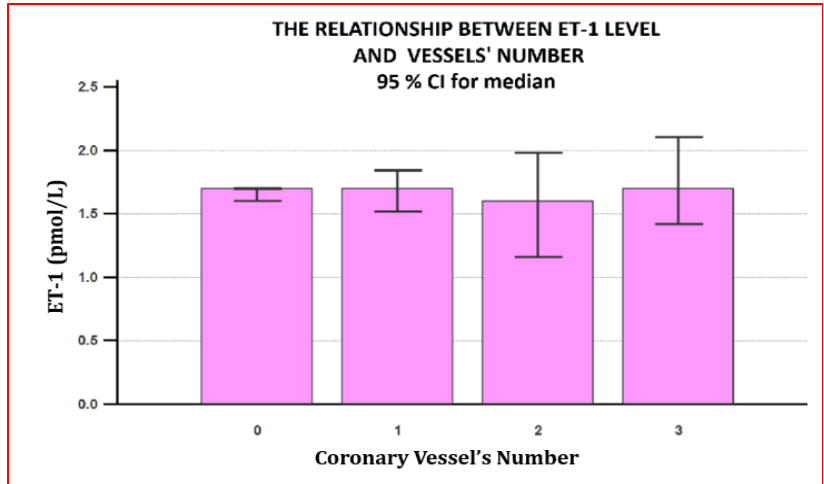
Figure 2. The relationship between plasma ET-1 concentration and the number of coronary lesions. The plasma concentration of ET-1 did not show significant differences either in terms of the type of coronary heart disease, microvascular versus macrovascular, either in terms of the number of coronary arteries involved for patients with obstructive coronary heart disease. 0—microvascular angina;